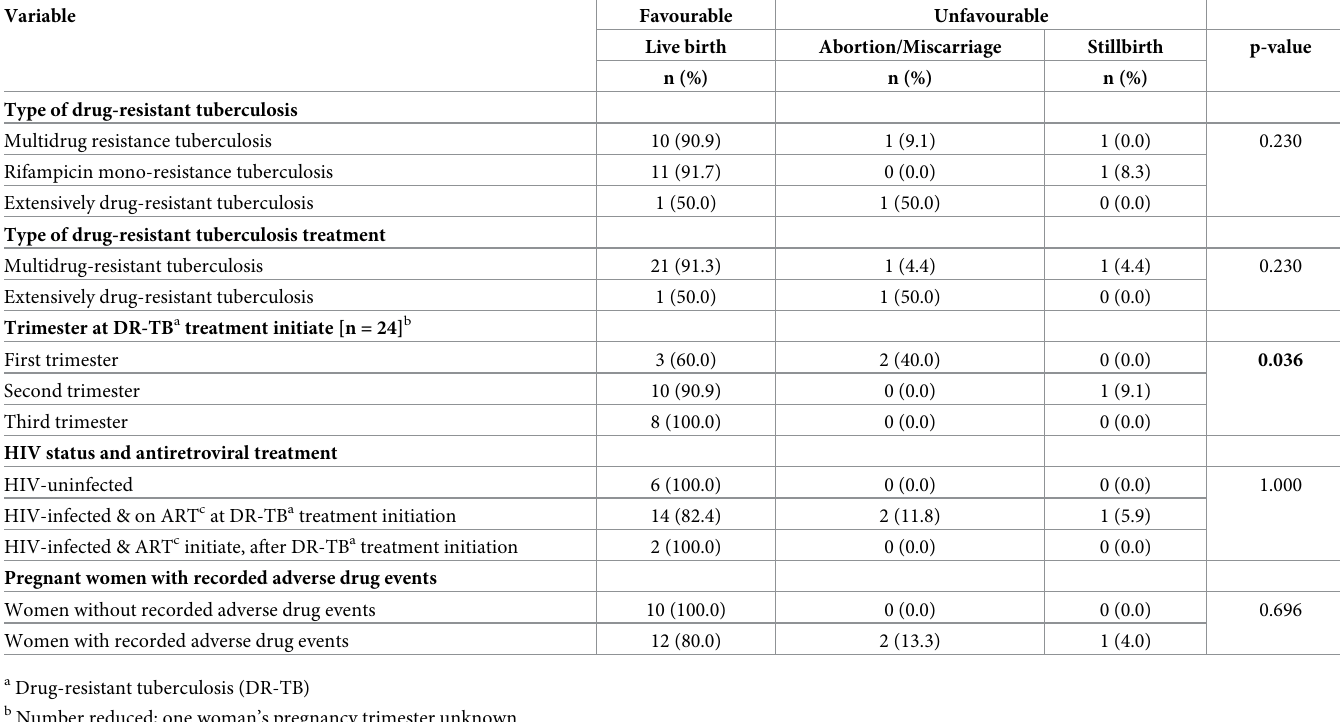
Table 2. Proportion of pregnant women with favourable or unfavourable birth outcome (n =